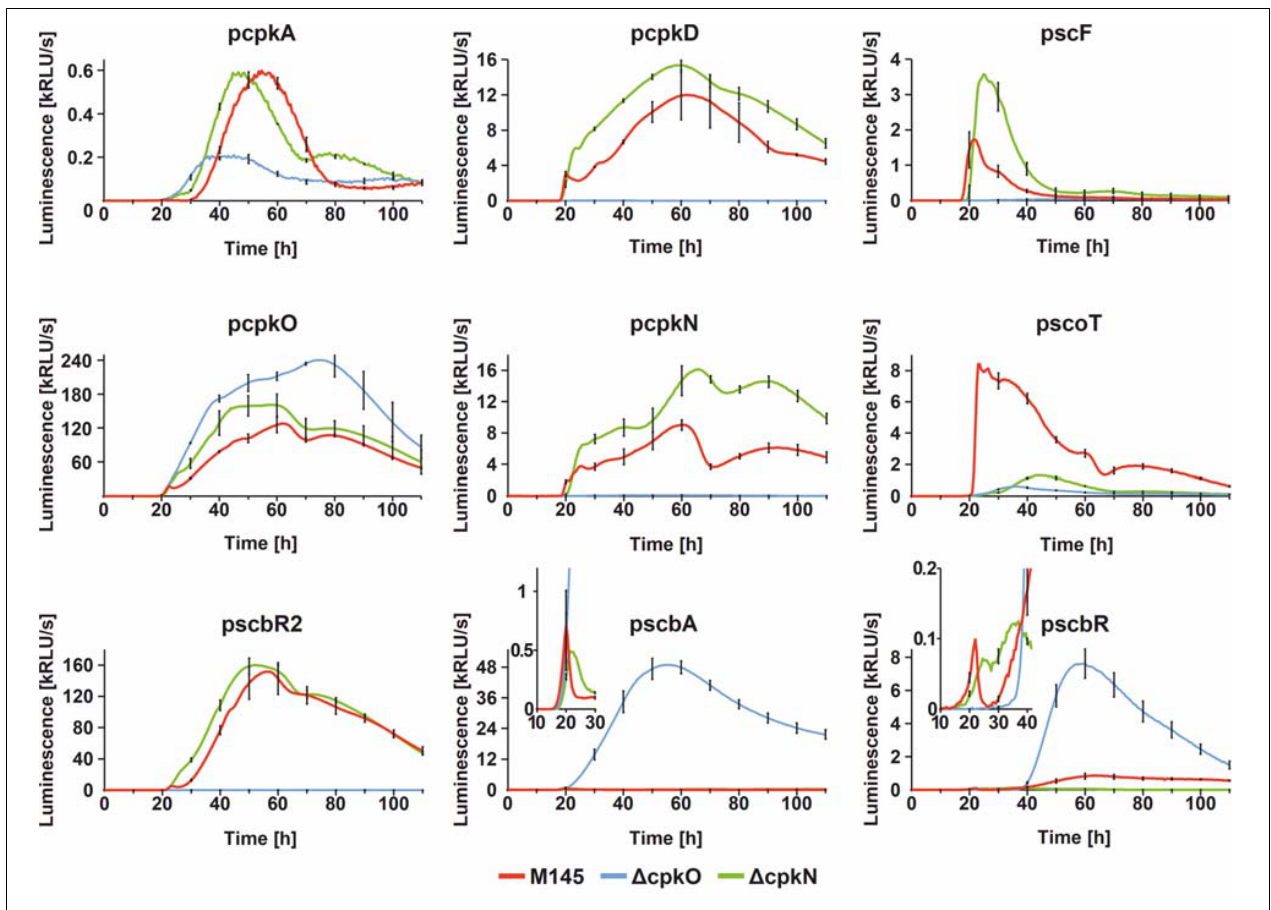
FIGURE 4 | Transcriptional profiles cpk cluster promoters. The charts show luciferase-based reporter system measurements over 110 h of growth with sampling time of 30 min. For clarity, standard deviation was shown for every 10 h time-point. In case of pscbA and pscbR profiles, parts of the graphs were zoomed in to better visualize the differences in earlier